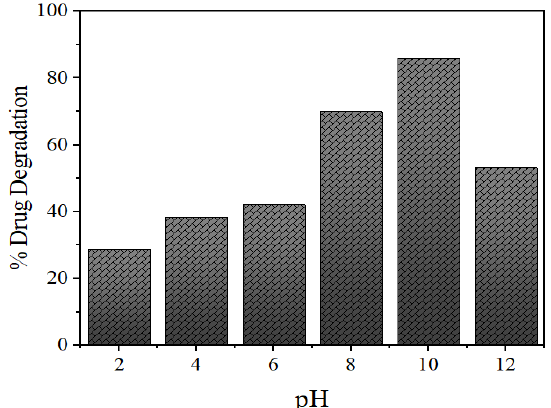
Figure 12. Effects of pH on photocatalytic degradation of NOFX in the presence of Mn:ZnSQDs under optimal conditions (25 mL of NOFX, 60 min irradiation, 60 mgs QDs). optimal conditions (25 mL of NOFX, 60 min irradiation, 60 mgs